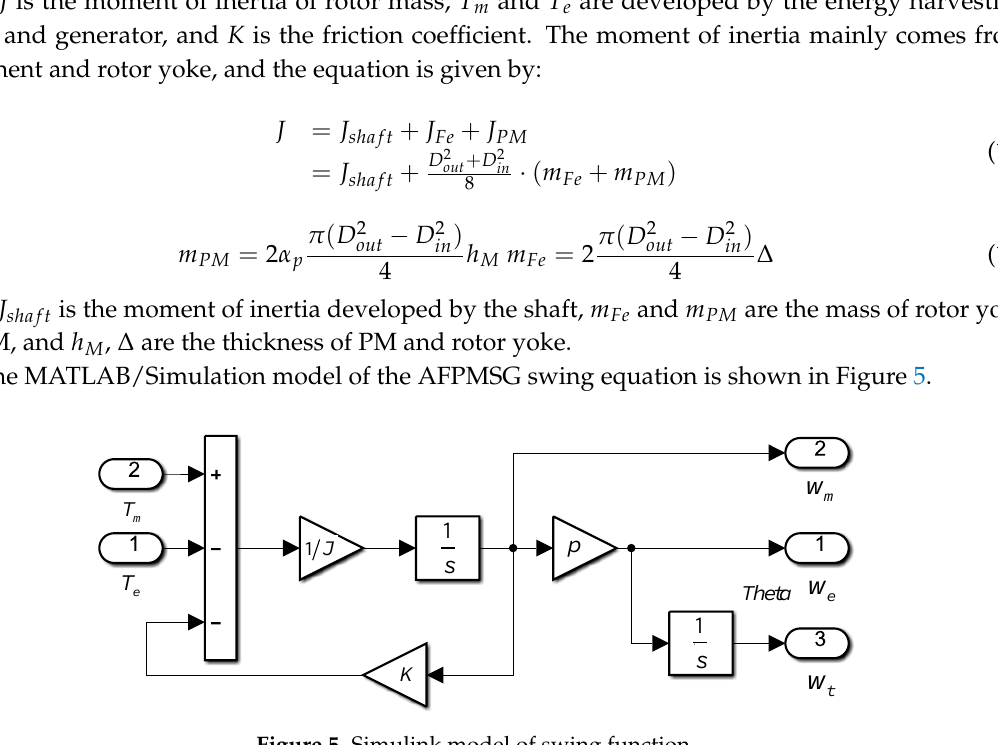
Figure 6. Dynamic characteristic analysis block diagram. 3. Dynamic Performance and Key Factor Analysis 3.1. Dynamic Performance Analysis In the direct driven generation system without any speed adjustment gear, the energy including the fluctuation and disturbance received by the generator, will directly reflect in the output performance, which depends on the structure parameters of generator. In this paper, dynamic performance analysis is researched via the starting process and response of the output voltage when there is disturbance. According to Table 1, the moment of inertia of stator coreless AFPMSG is 0.957 kgm 2 , the friction coefficient is 0.09, stator resistant is 3.3  , and induction is L d = L q = 0.008 H . Those parameter data are obtained from theory calculation and the simulation of Maxwell ANSOFT. Figure 7 shows the output voltage curves of the starting up with 100 Nm rated input torque (a) and voltage response to the disturbance with 5 Nm step torque input (b). It can be observed that the generator needs to take some time